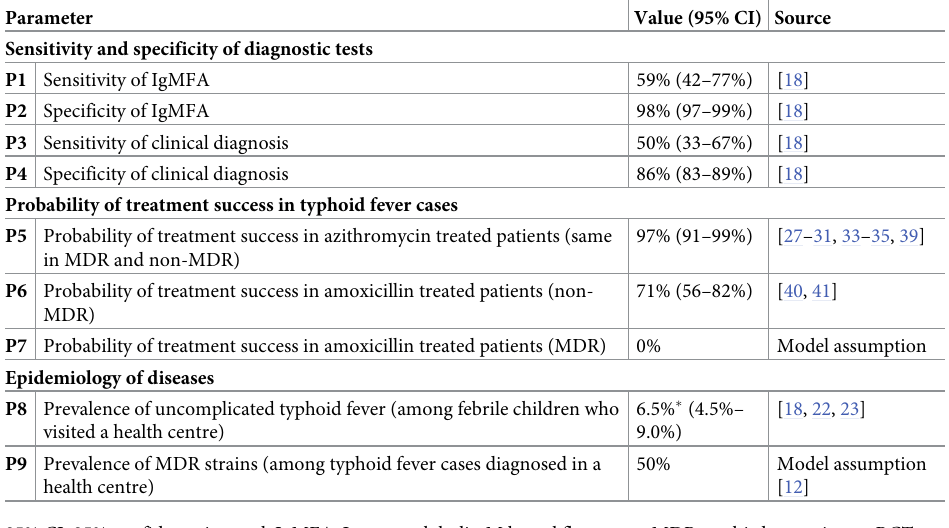
95% CI, 95% confidence interval; IgMFA, Immunoglobulin M lateral flow assay; MDR, multi-drug resistant;